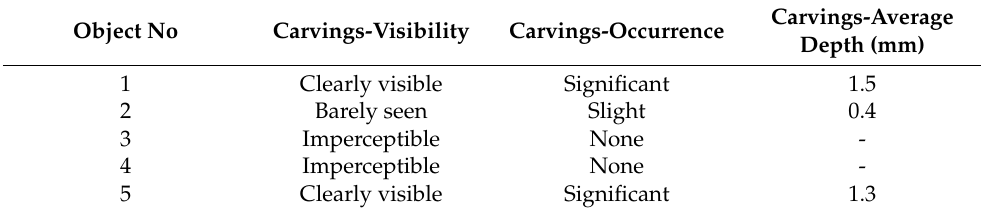
Table 5. Petroglyph carvings observed on the scanned object